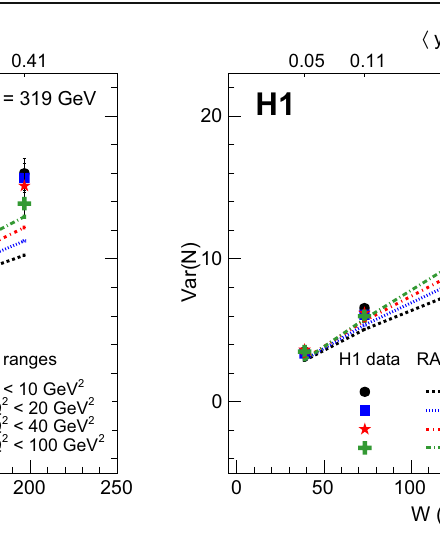
multiplicity distributions measured in ep DIS at √ s = 319GeV as a function of W . The measurement is repeated in four ranges of Q 2 as indicated. The phase-space is further restricted as shown in